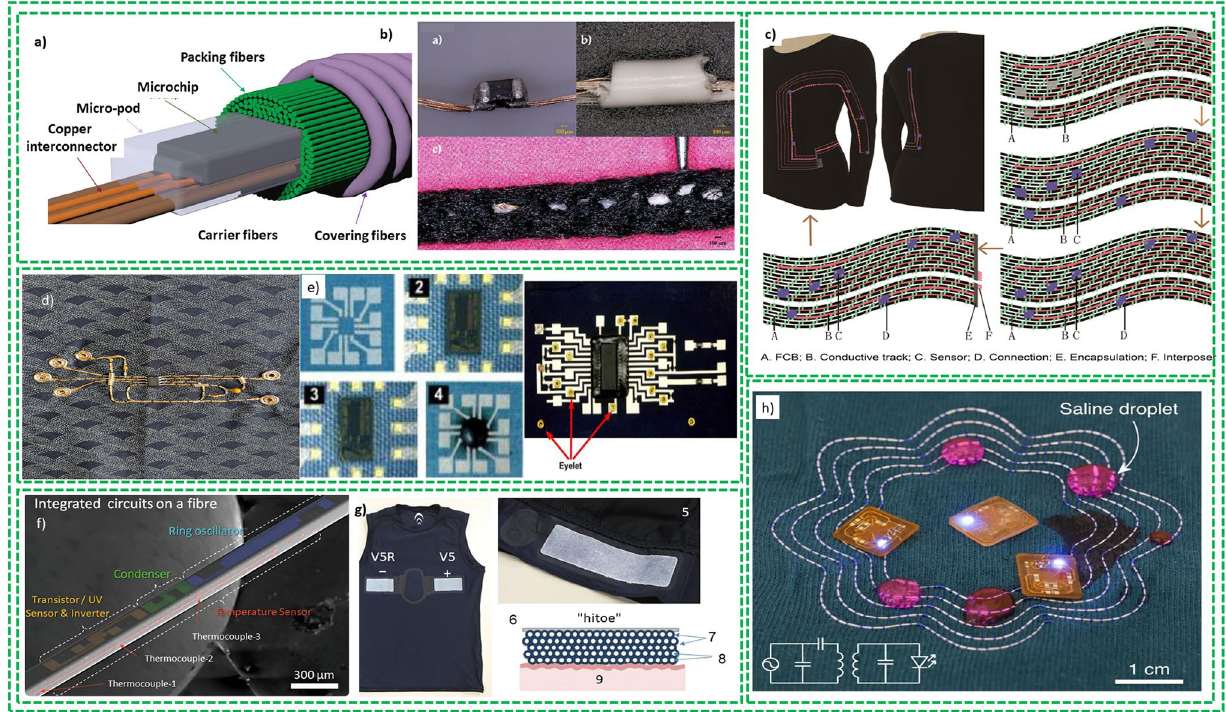
Fig. 22 a and b Cross-sectional view of an electronically functional yarn, Photographs of prototype temperature-sensing yarn manufacturing process. An eight-strand copper wire was soldered onto the thermistor; the thermistor, copper wire and two polyester yarns were encapsulated with 9-20801 resin with 0.87 mm thickness; the final yarn with the position of the thermistor indicated by a needle. Reprinted with permission from Refs. [240, 241]. c Electronic tracks on textile substrate using interposers. Reprinted with permission from Ref. [225]. d and e Single-lay- ered P-FCB system manufacturing process; Implementation of multi-layer connection using eyelet. Reprinted with permission from Ref. [242]. f SEM image of electronic devices fabricated on a single microfiber Reprinted with permission from Ref. [246]. g Designed smart ECG garment system. Reprinted with permission from Ref. [247]. h Embroidered conductive yarn circuit. Reprinted with permission from Ref.